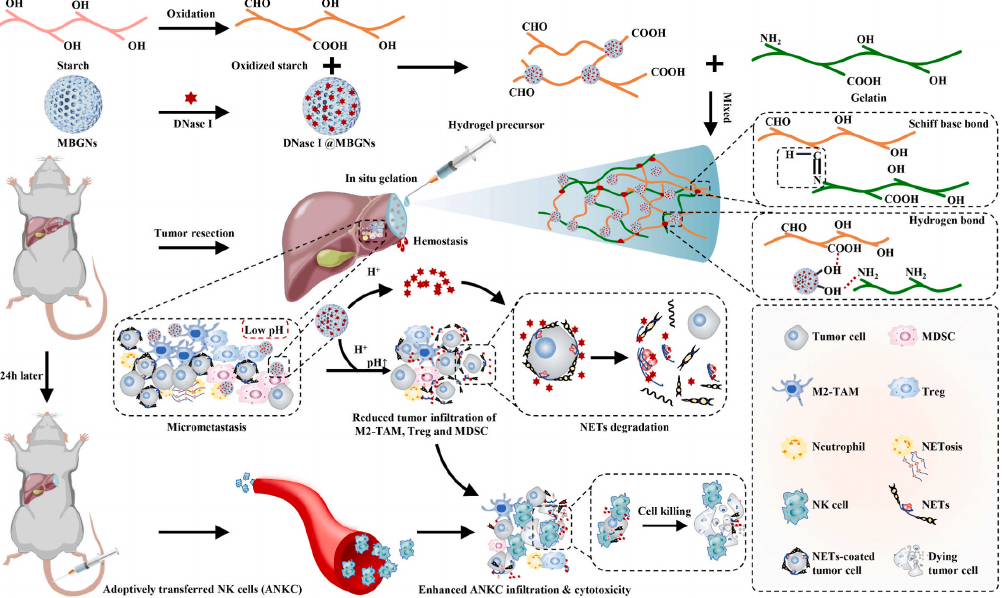
Figure 3. Schematic diagram of mesoporous plexiglass loaded with hydrogel as the drug carrier and the polymer binder. Such a scheme subtly covalently binds MBGNs and polymers by carboxyl groups of gelatin and starch with hydroxyl groups on mesoporous surfaces. This strategy can be applied to the wound of hepatocellular carcinoma surgery in situ, and NK cells are the main target cells and activation sites. Reprinted with permission from Ref. [52]. Copyright 2022 Elsevier Ltd.